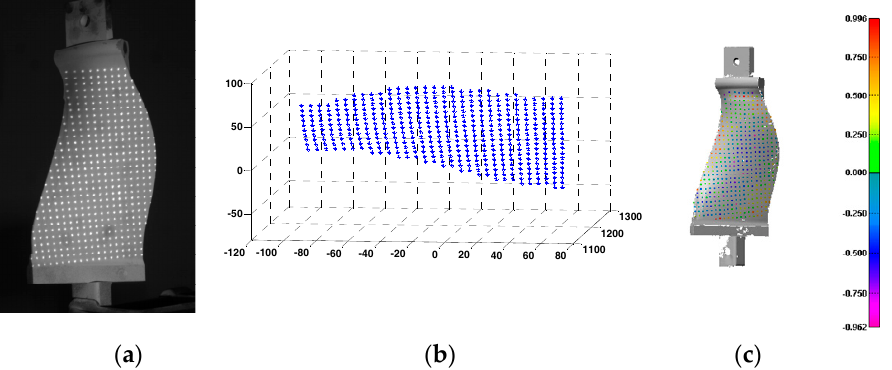
Figure 12. 3D reconstruction of an engine blade by the proposed method. ( a ) Laser spots are projected onto the surface of the engine blade to be reconstructed. ( b ) Reconstructed 3D points. ( c ) Error distribution of the registration.